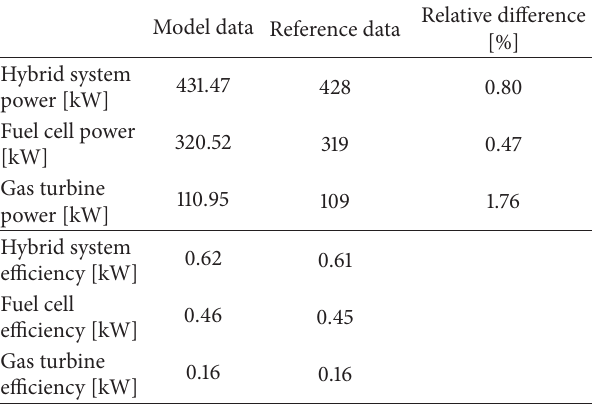
Table 9: Comparison of the data obtained with the model and experimental data studied by evaluating an equivalent useful area equal to 85% of the effective area (dfc = 3200 A/m 2